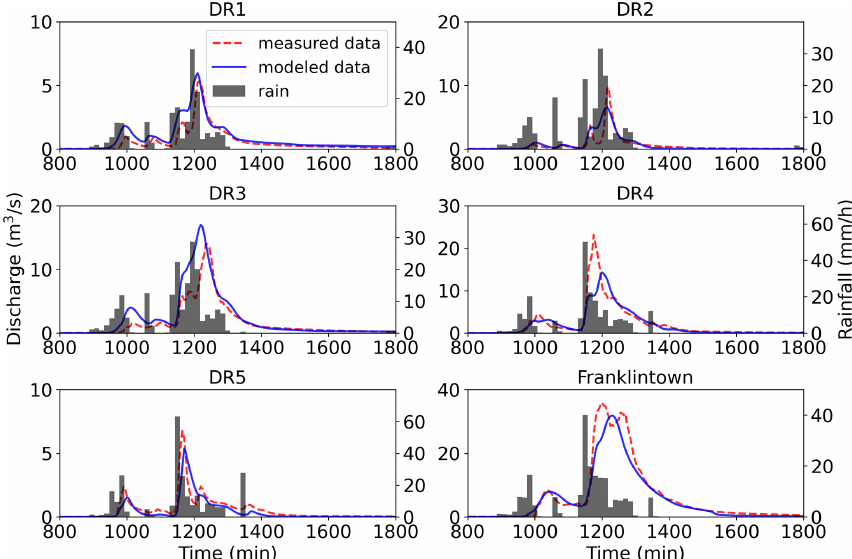
Figure 3. Hydrographs and rainfall for the 14 August 2011 storm event. Time refers to minutes from the start of the model